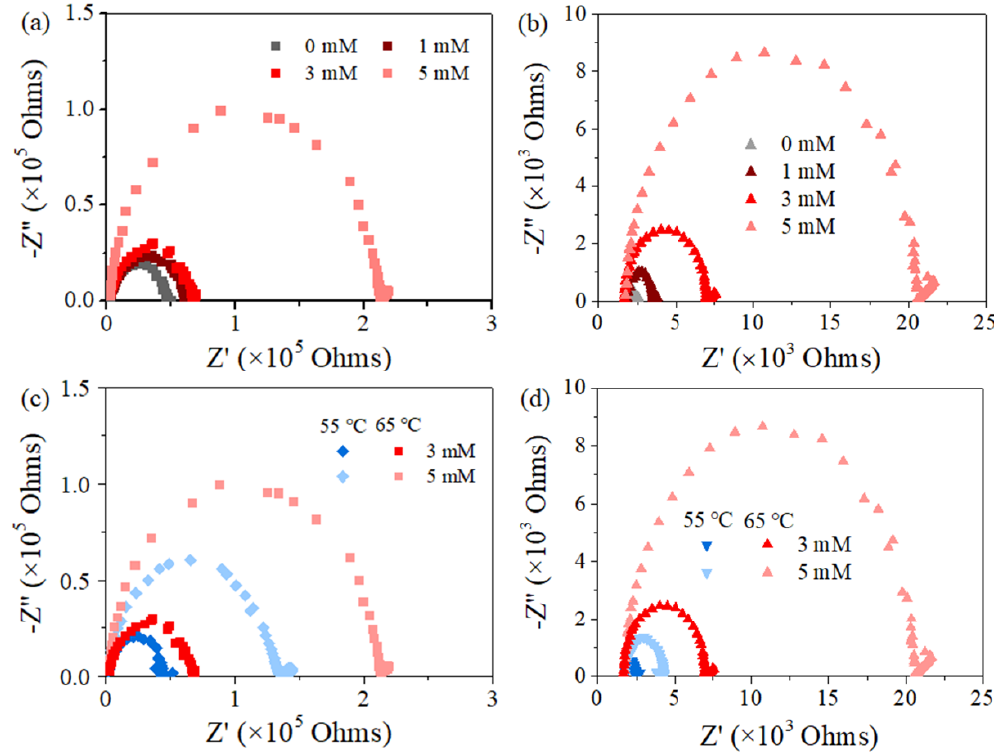
Figure 6. Nyquist plots of EIS data for fouled membrane of PVDF ( a , c ) and PTFE ( b , d ). Feed with different PDS concentrations ( a , b ) and temperatures ( c , d ) according to Figures 4 and 5, respectively.